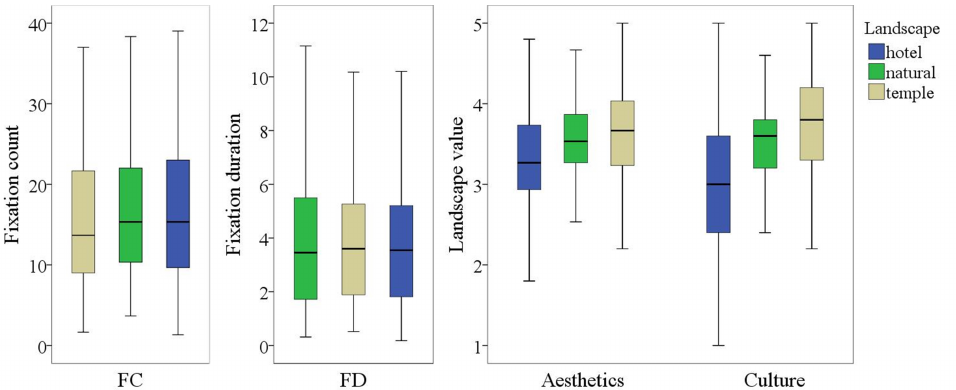
Figure 5. Boxplots of eye movement and value assessment for the three landscapes. The fixation count is measured in counts (c), and the fixation duration is measured in seconds